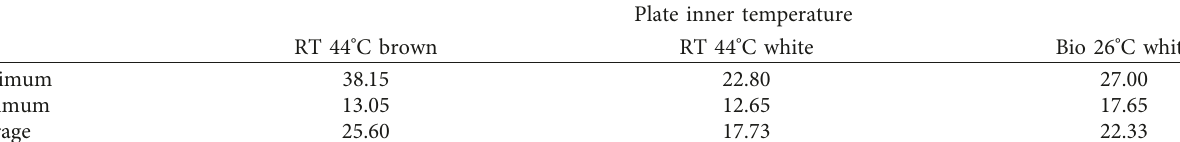
Table 11: Plate inner temperature measurements of Test 2 ( ° C).